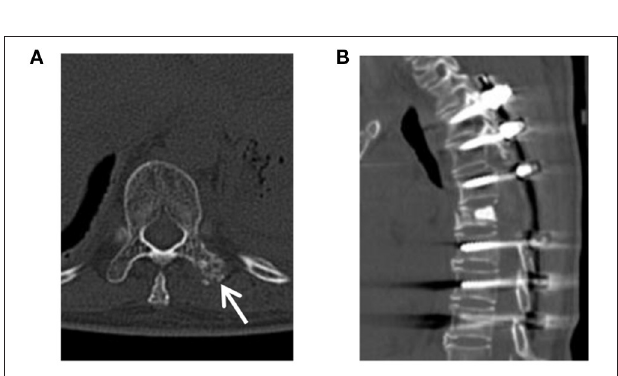
FIGURE 4 | CT of a 49-year-old female patient with mediastinal epithelioid haemangioendothelioma (EHE) at the latest review. (A) CT revealed that the lesion of the left transverse process of the T10 vertebra was small and localised (arrow). (B) A CT image of a sagittal reconstruction showed that the internal fixations of thoracic vertebrae were